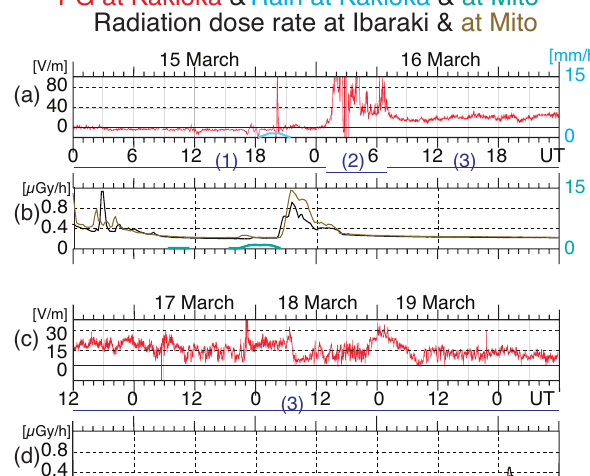
Fig. 3g and h. The nighttime fair-weather baseline PG stayed low while minor recoveries of the baseline PG started, reaching to about 10 V m − 1 by the end of this period. The radiation dose rate continuously decayed with a half-decay time of about 10 days that corresponds to 131